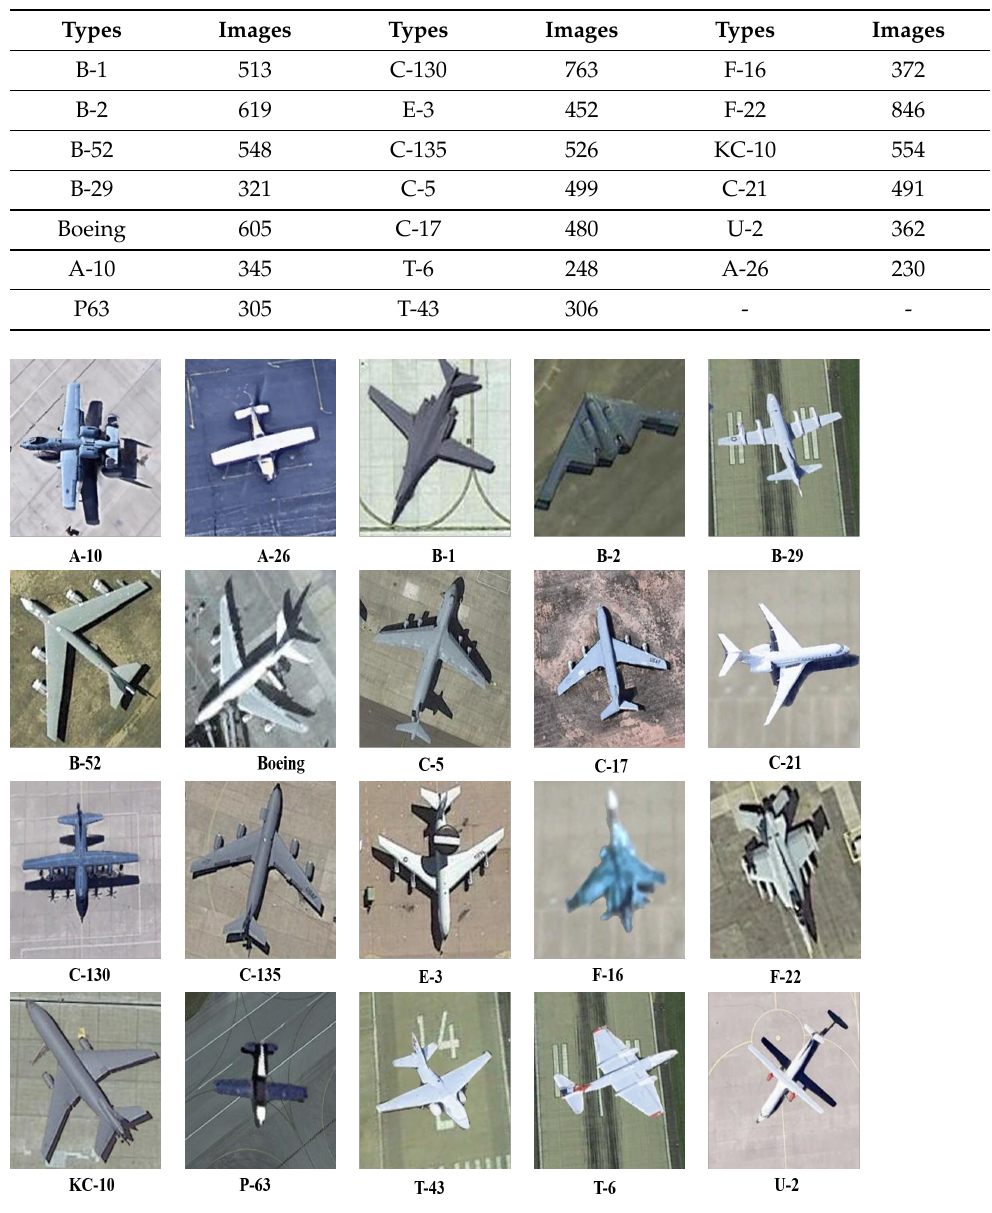
Figure 3. Samples of 20 aircraft types in the MTARSI